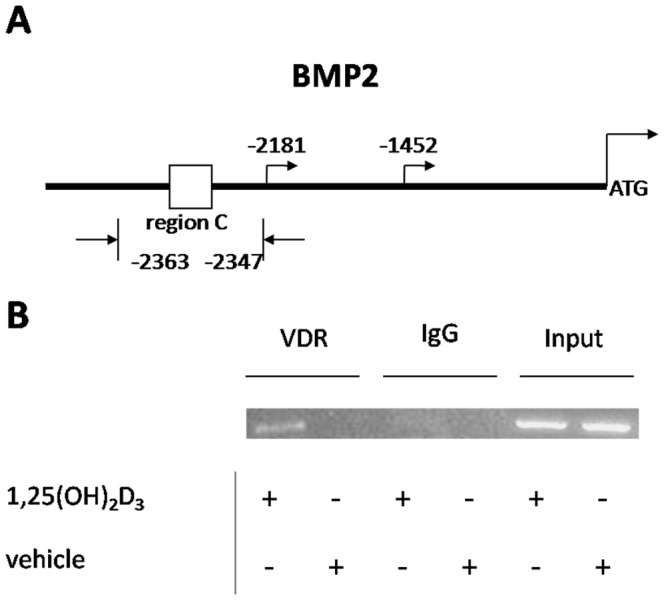
VDR binding to BMP2 promoter region in vitro.ChIP assays were performed on UMR-106 cell extracts using anti-VDR antibody with or without 1,25(OH)2D3 administration. Normal IgG was used as a negative control. DNA was precipitated with either anti-VDR antibody or normal IgG. The primer pairs of putative VDREs in rat BMP2 promoter region (as described in “Materials and Methods”) were used to amplify the ChIP DNA fragments. A. The site of BMP2 promoter region C and the two corresponding promoters (−2181 and −1452) based on the conserved sequence data in mouse. B. The results showed that VDR bind to BMP2 promoter region C.